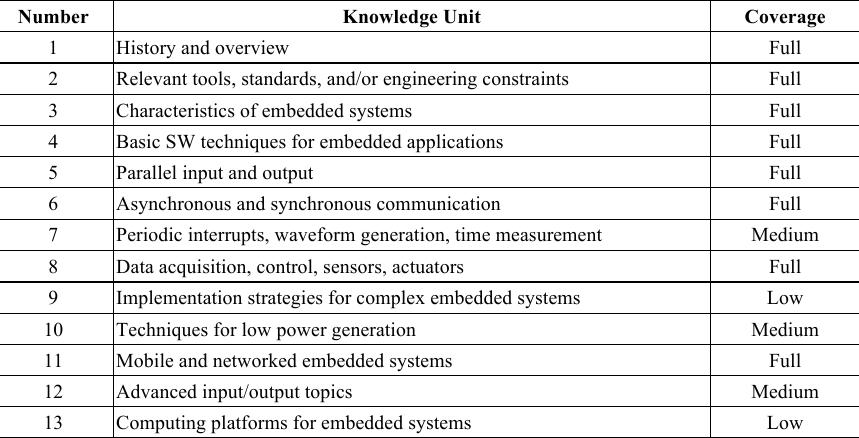
Table 2. Arduino coverage of embedded systems